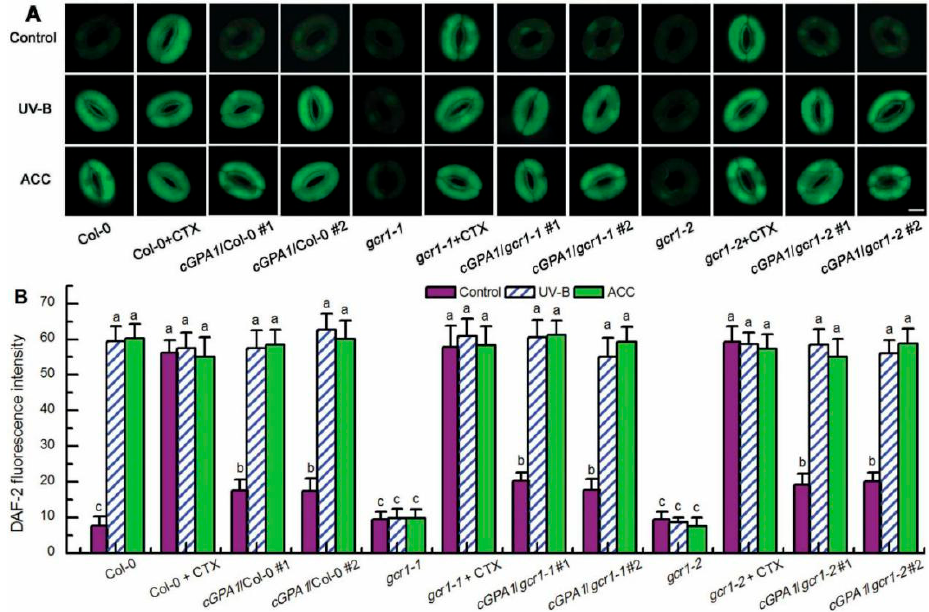
Figure 5. GCR1 mediated UV-B- and ethylene-induced NO generation in guard cells via activating G α subunit GPA1. Leaves of the wild-type Col-0, gcr1 mutants, and transgenic plants cGPA1/Col- 0/gcr1-1/gcr1-2 were floated on MES buffer in the absence or presence of 400 ng/mL CTX (CTX) or 100 μ mol/L ACC (ACC) and exposed to light alone (Control) or with 0.5 W/m 2 UV-B (UV-B) for 3 h. Then the images ( A ) and fluorescence intensities ( B ) of guard cells preloaded with DAF-2DA were recorded. For ( A ), scale bar = 10 μ m. For ( B ), data are shown as means ± SE ( n = 3), each with 20 stomata. Means with different letters are significantly different at p < 0.05.